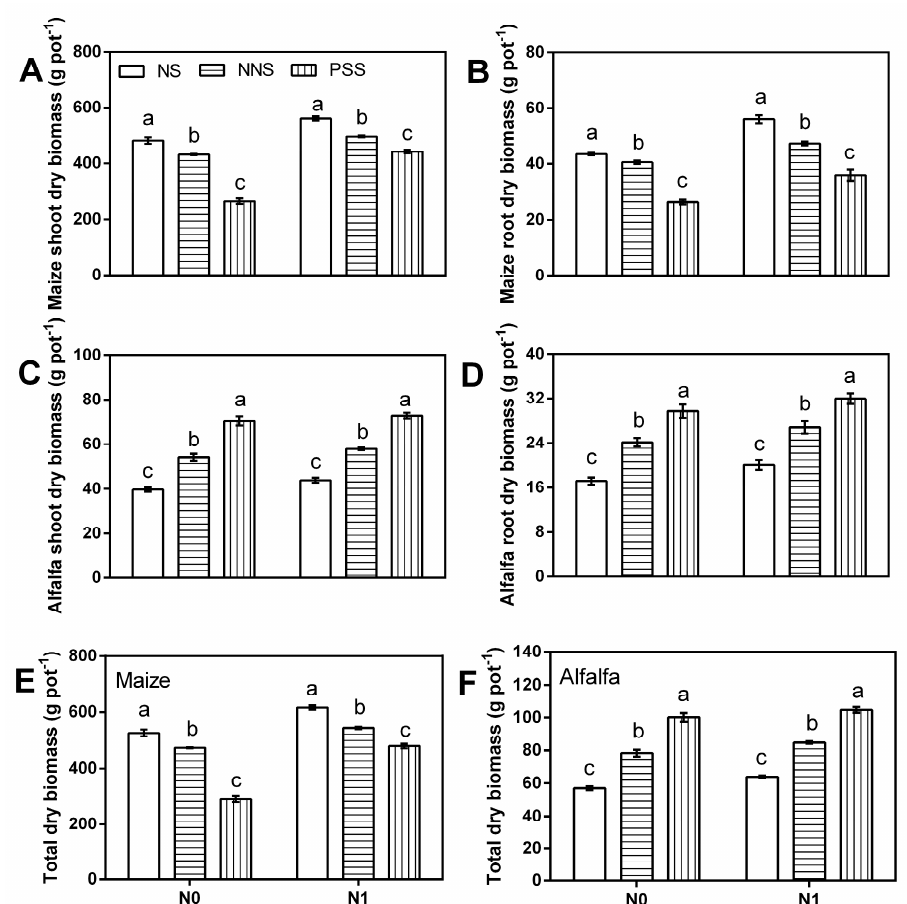
Figure 2. Effects of root separation and N addition on maize shoot and root ( A , B ), alfalfa shoot and root ( C , D ) and total dry biomass ( E , F ) in 2015 and 2016. Bars are means ± SD. Different lowercase letters indicate significant differences in maize and alfalfa dry biomass among different root separation treatments at the same nitrogen level at the p ﹤ 0.05 probability level. N0 and N1 represent no N fertilizer addition and N fertilizer addition (10.2 mg N pot − 1 ). NS represents no root separation between the maize and the alfalfa, NNS and PSS represent maize and alfalfa root separation with a nylon net barrier and a plastic sheet barrier, respectively.